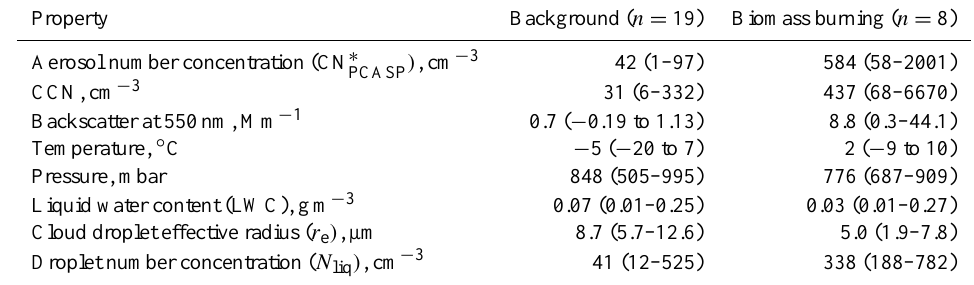
Table 7. Median properties and ranges for all background and biomass burning cloud cases in the multi-campaign assessment.